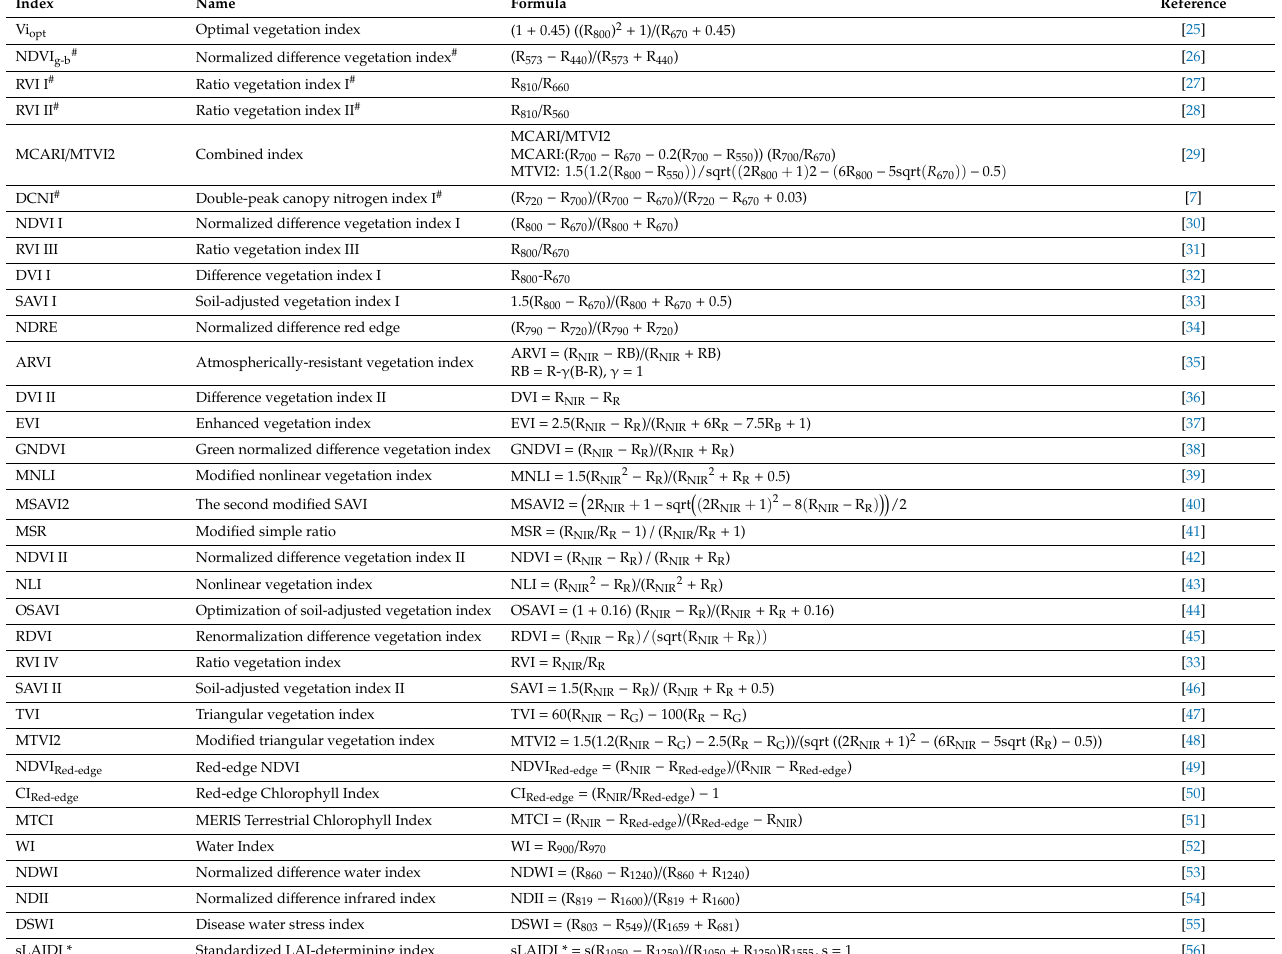
Table 3. Summary of partial vegetation